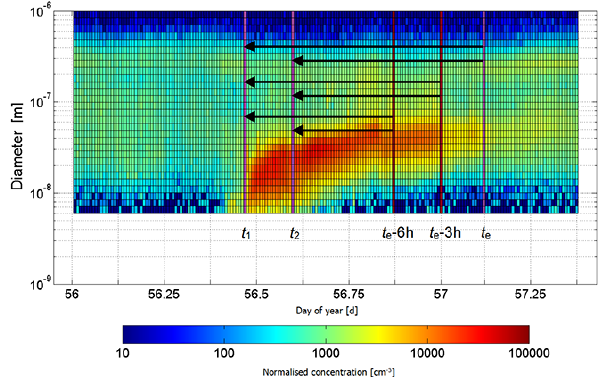
Figure 1. Determination of the start ( t 1 ) and end ( t 2 ) time param- eters of the nucleation, and the end of the particle growth ( t e ) . The three arrow pairs correspond to three backward trajectories arriving to the measurement site at times of t e , t e − 3h, and t e − 6h, and de- termine three limiting segmental pairs corresponding to t e − t 1 and t e − t 2 , t e − 3h − t 1 and t e − 3h − t 2 , and t e − 6h − t 1 and t e − 6 h − t 2 on the air mass